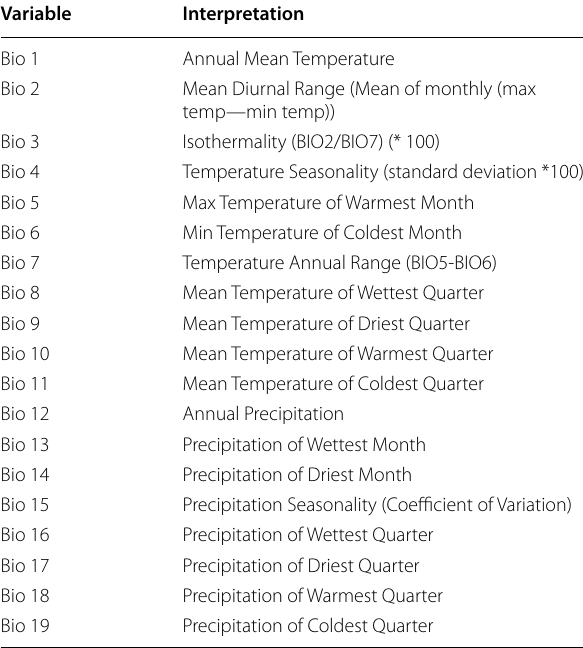
Table 1 Environmental variables used for the study